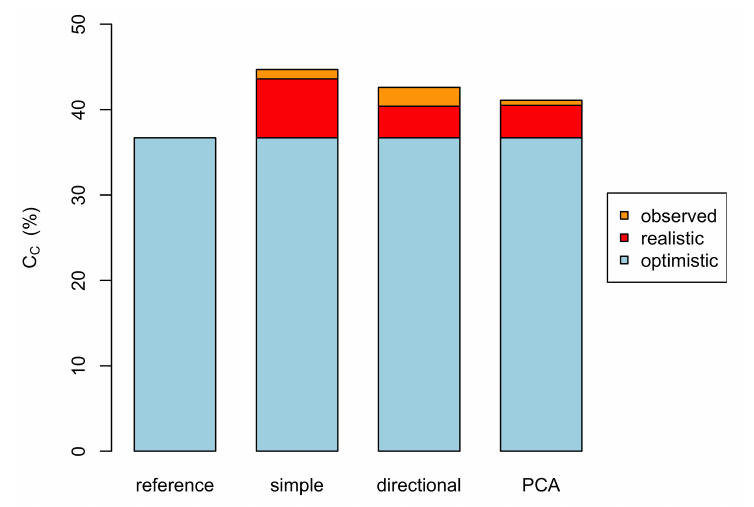
Figure 12. Potential improvement in annual productivity shown as the observed and potentially increased capacity factor, where the actual output is the blue bar, the red section the additional production which should be achievable with responsive maintenance, and the orange section an optimistic high expectation of the